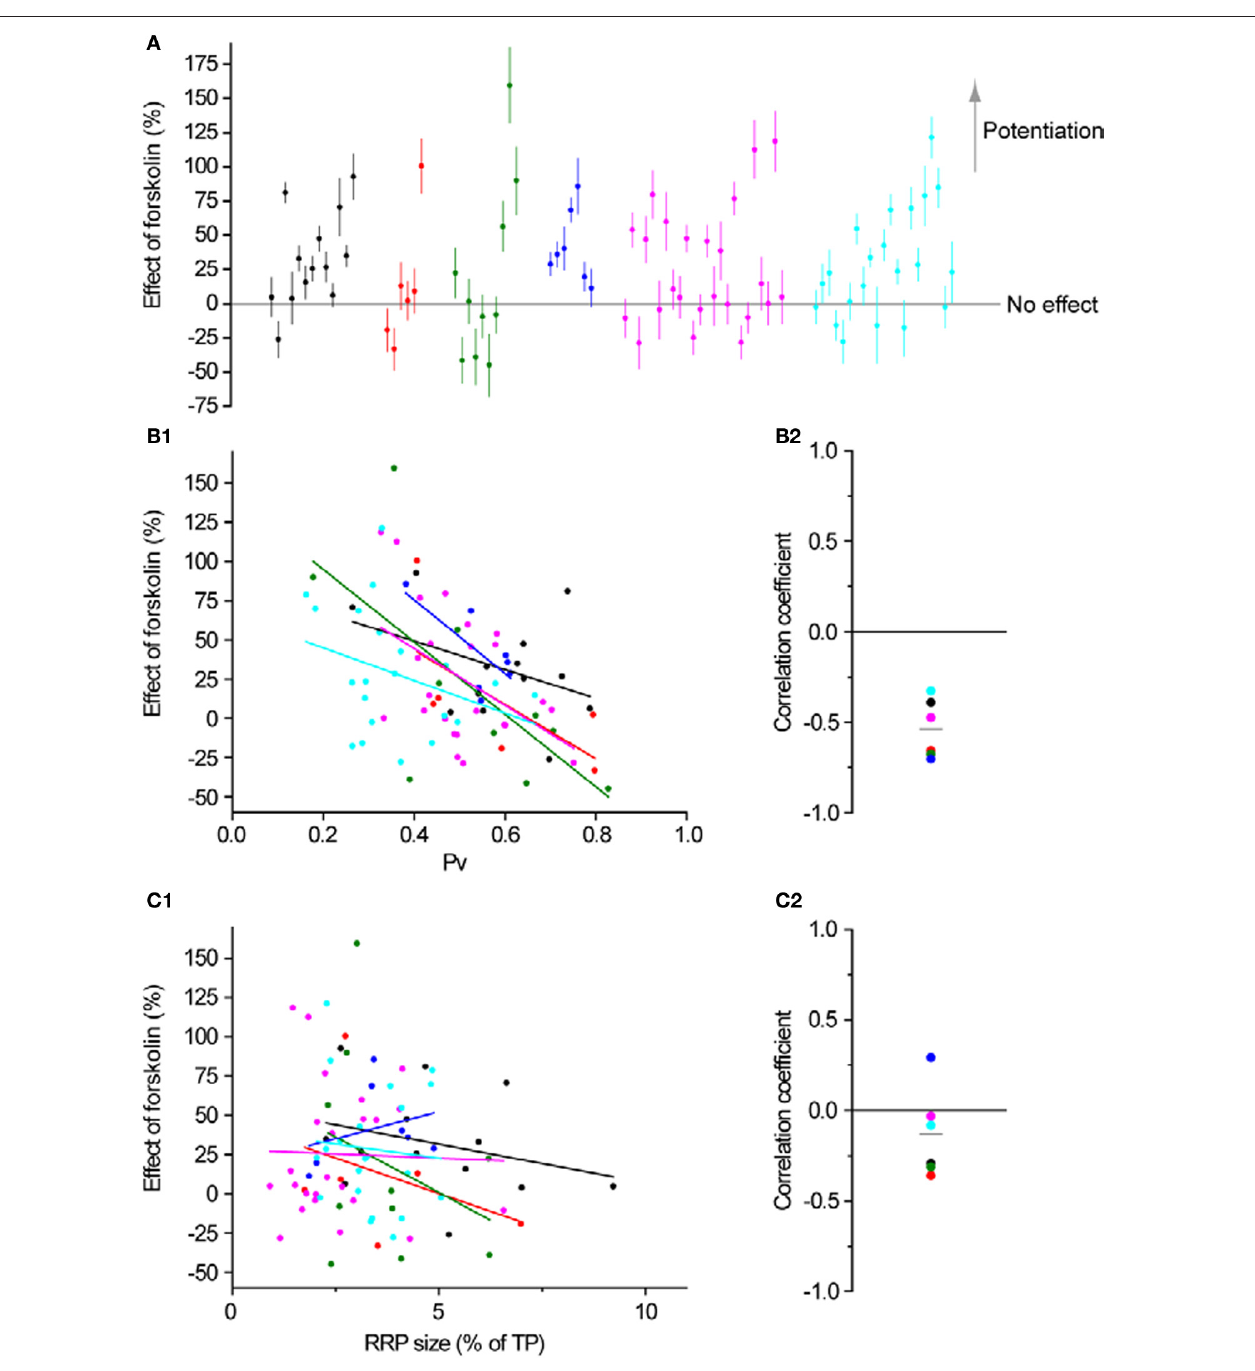
FIGURE 8 | Synapses are differentially modulated by forskolin according to their baseline Pv . (A) Effect of forskolin on exocytosis in response to a single AP. Different colors represent individual experiments, while each dot shows the effect of the drug on a single synapse with its SE. Experiments are ordered according to their responses to an individual AP from highest (left) to lowest (right). Within an experiment, synapses are also sorted from most (left) to least responsive (right). (B1,B2) Effect of forskolin is negatively correlated with Pv . (B1) Each dot is a synapse and the coloring scheme is the same as in (A) . Lines represent best fits for each experiment, colored accordingly. (B2) There is a negative